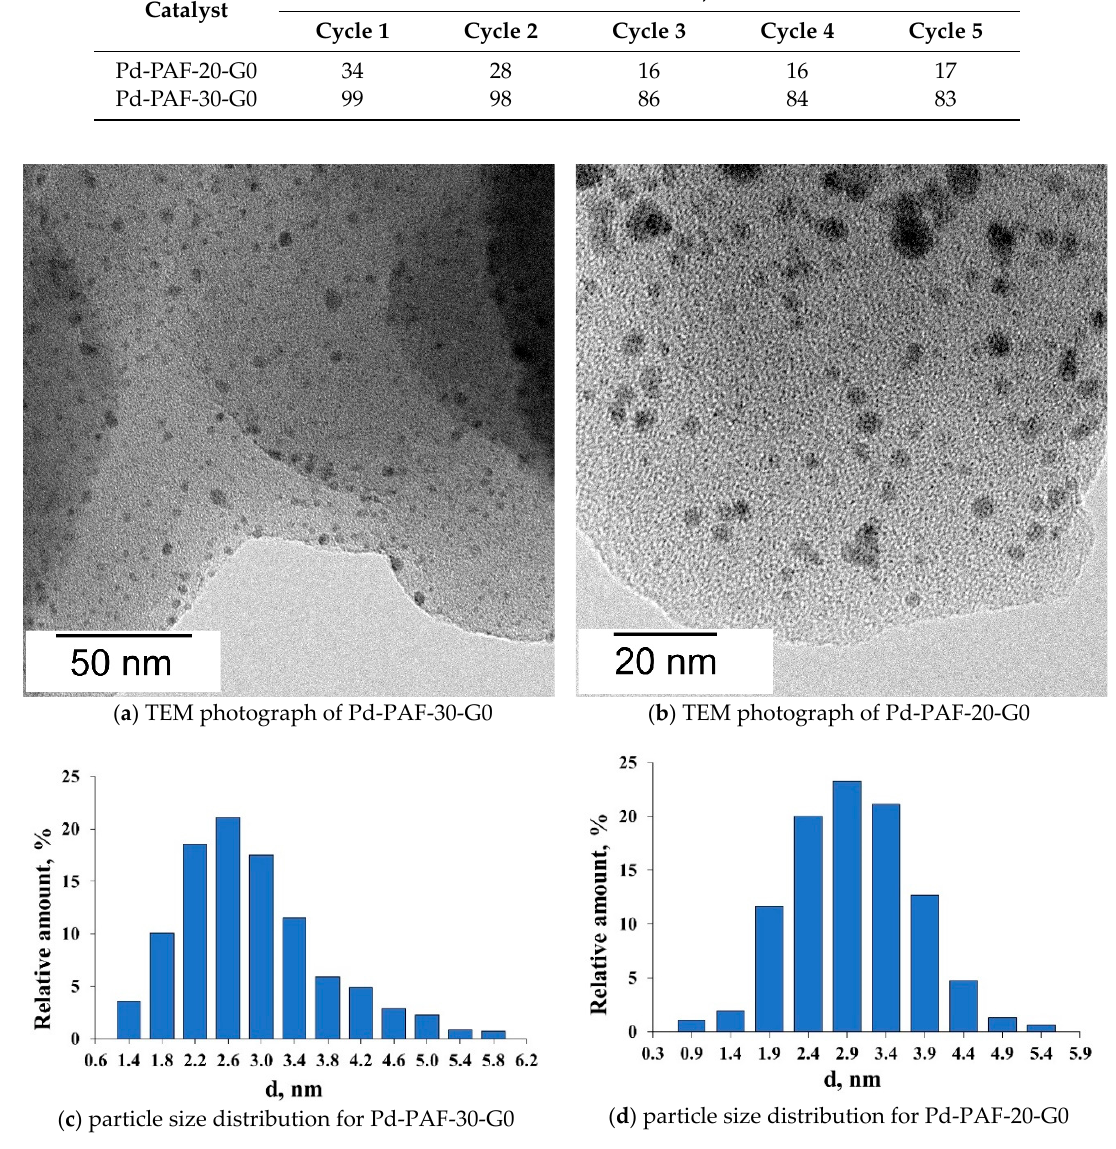
Figure 6. TEM microphotographs and particle size distribution for Pd–PAF-20-G0 and Pd-PAF-30-G0 after five runs of the recycle process.